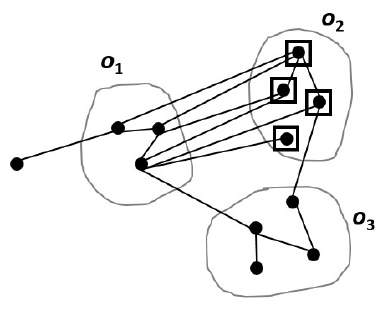
Figure 6: Nodes belonging to the lower approxima- tion ICSN ( o 2 → o 1 ) of the inter-component saccade neighborhood, from o 2 to o 1